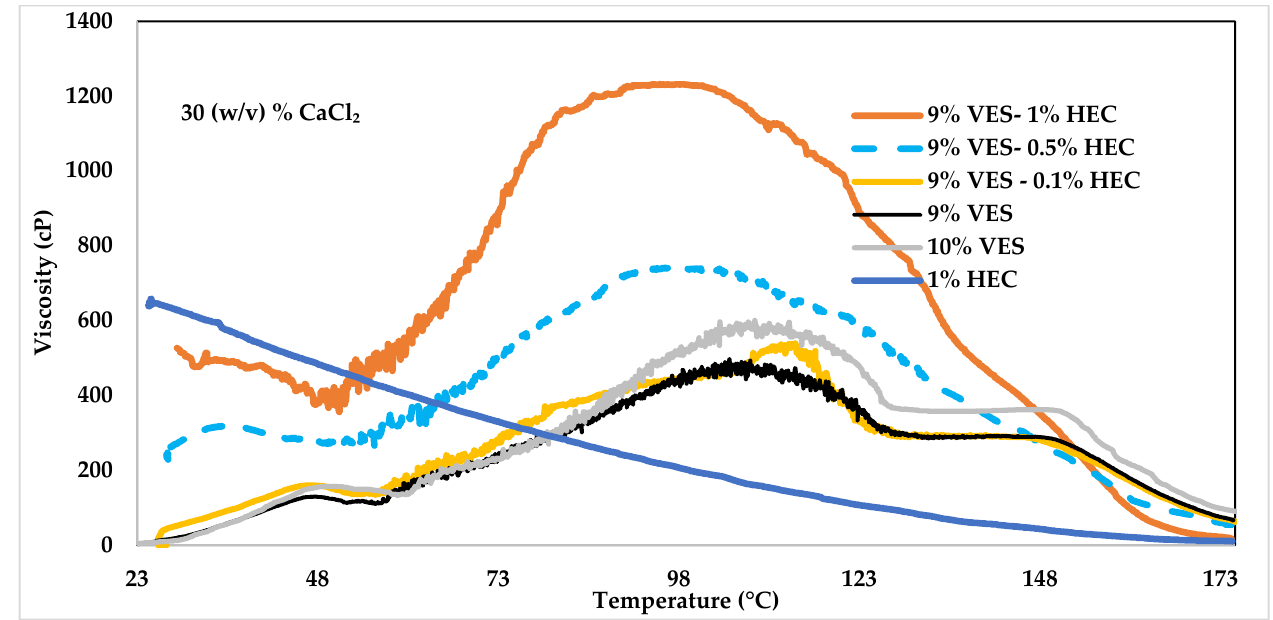
Figure 7. Viscosity change with respect to temperature at 100 1/s shear rate, 9% ( v/v ) VES fluid prepared with 30% ( w/v ) CaCl 2 in fresh water and 1% HEC polymer concentrations.